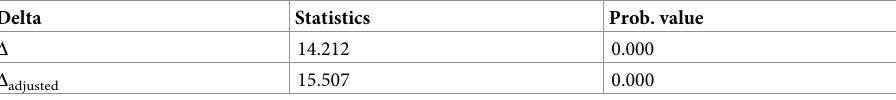
Table 5. Pesaran and Yamagata slope homogeneity test estimates.